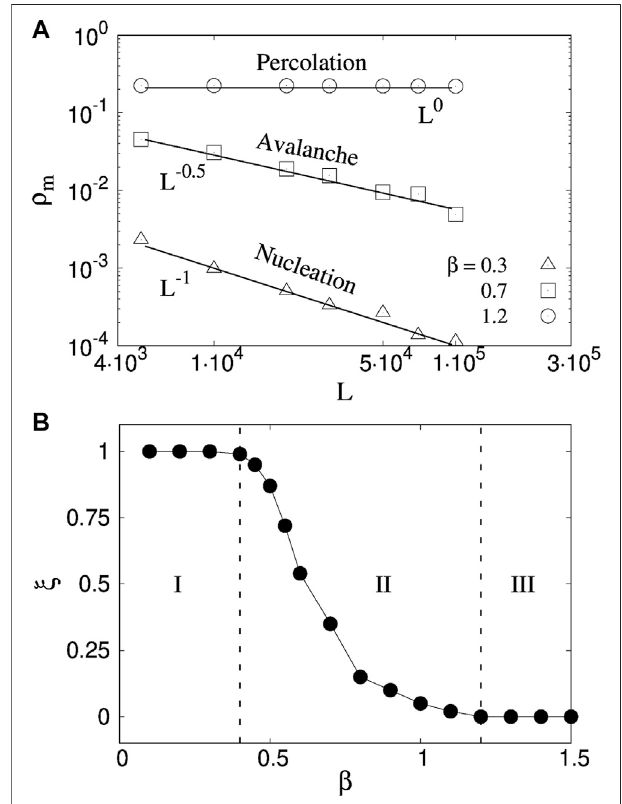
FIGURE2| (A) Effect ofsystem size L on ρ m for β (cid:1) 0.3, 0.7and 1.2. L is varied in between 5 × 10 3 and 10 5 . Three regions are observed here (1) Nucleation: ρ m ∼ L − 1 (2) Avalanche: ρ m ∼ L − ξ ( β ) (3) Percolation: ρ m ∼ L 0 . (B) Variation of ξ with β . ξ (cid:1) 1 and 0 in the region 1 and 3 respectively. In the intermediate region II, ξ decreases continuously with β